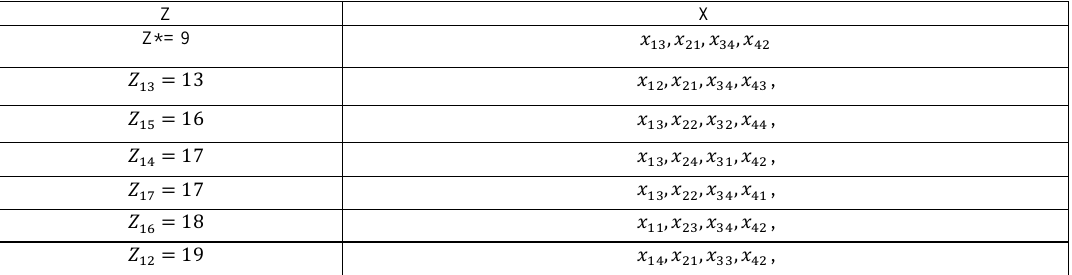
Table 2. Results from the random